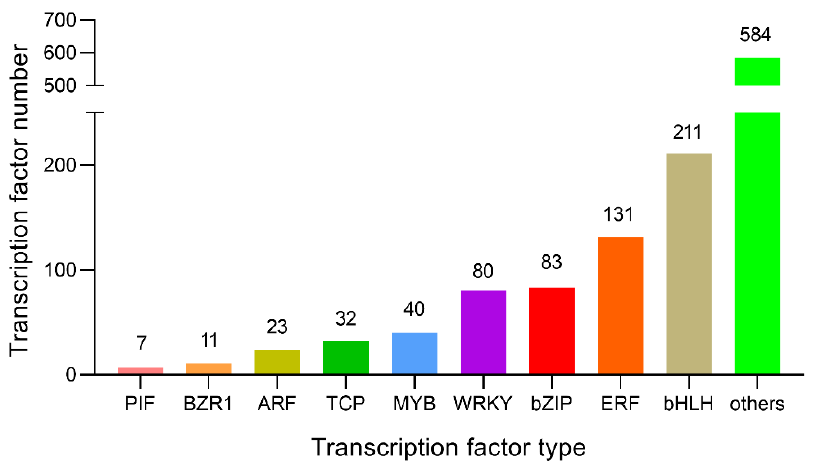
Figure 9. Statistics analysis of differentially expressed transcription factors. From the RNA-seq data analysis, 1202 differentially expressed TFs were significantly enriched, including PIF, BZR1, ARF, TCP, MYB, WRKY, bZIP, ERF, bHLH and other types of TF families. Table 1. Thirty transcription factors expression analysis with log2 |Fold Change| ≥ 3 based on RNA-seq